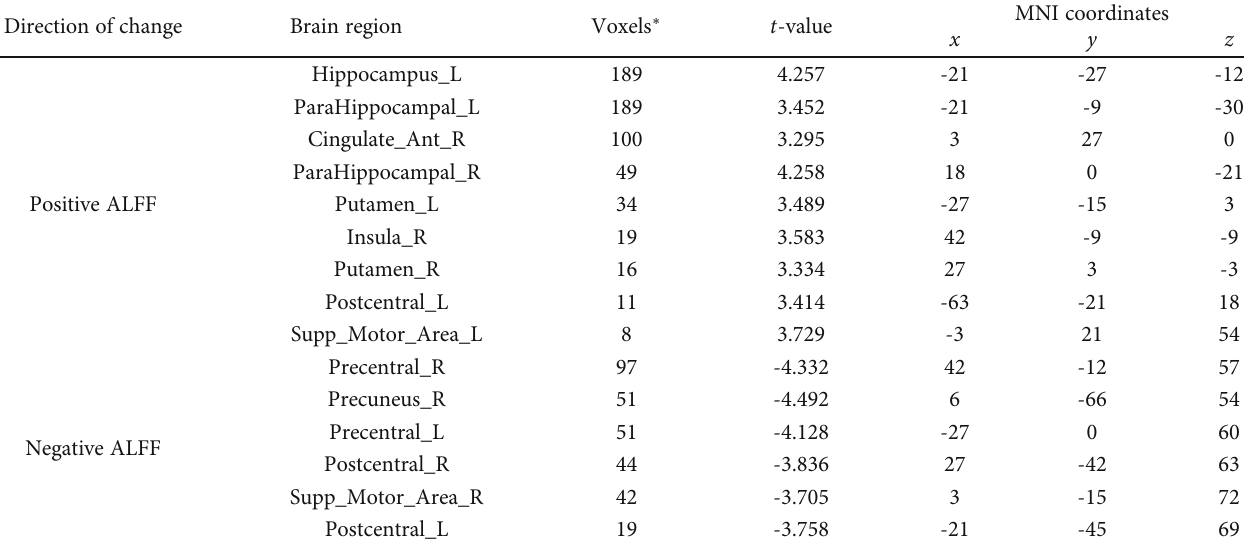
Table 2: Relative regional changes in ALFFs at 2 months ∗ in upper-limb amputees ( n = 16 ) compared to normal control subjects ( n = 8 ). Direction of change Brain region